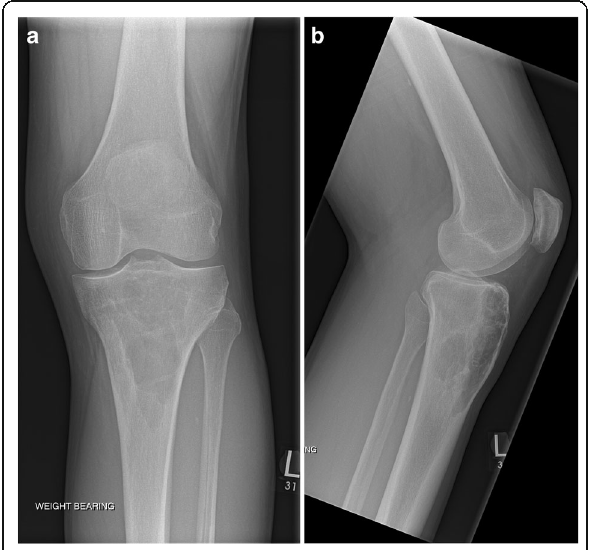
Fig. 14 Chest radiograph of the same patient showed an expansile mixed lytic/sclerotic lesion in the lateral aspect of the left clavicle